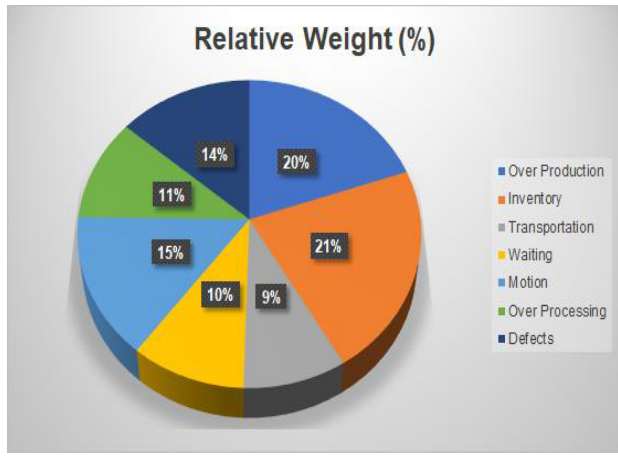
Figure 4. Pie chart of relative weight (%) of 7